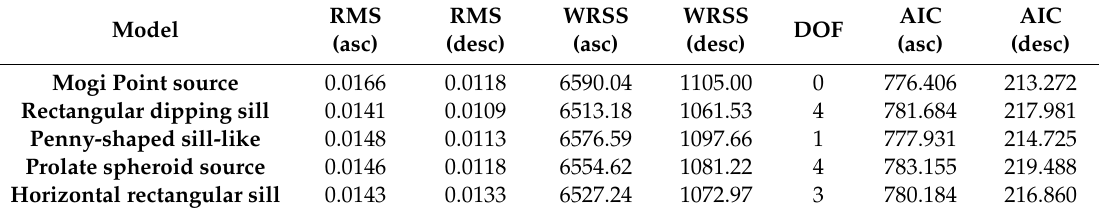
Table 2. Statistical values between the di ff erent source geometries tasted in the InSAR modeling for the descending and ascending interferograms. The RMS corresponds to the root mean square of the residual, and the WRSS corresponds to the residual sum squares weighted with the covariance.